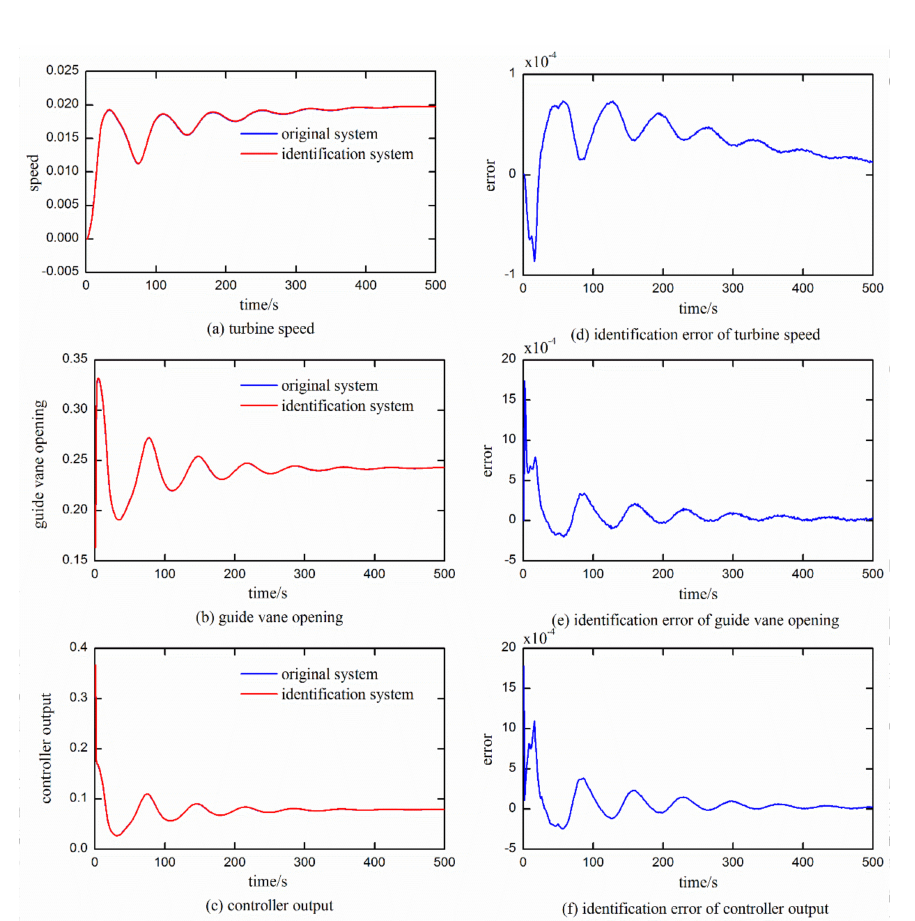
Figure 7. Comparison between the outputs of the three parts of the original and the identification systems under frequency disturbance: ( a ) outputs of the turbine speed; ( b ) outputs of the guide vane opening; ( c ) outputs of the controller output; ( d ) identification error of the turbine speed; ( e ) identification error of the guide vane opening; and ( f ) identification error of the controller